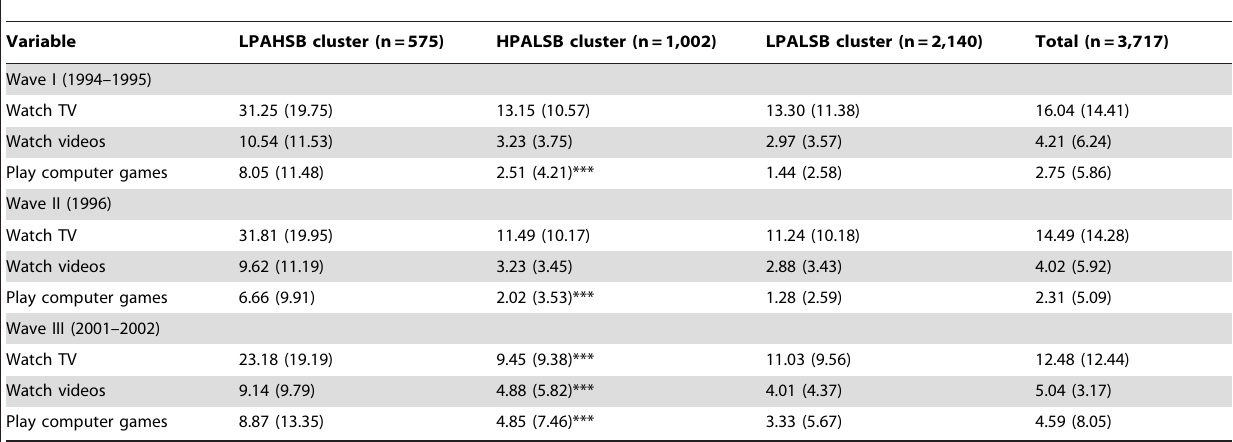
Table 1. Participants’ time spent in sedentary behaviors (hours/week) in the three clusters and the total sample.